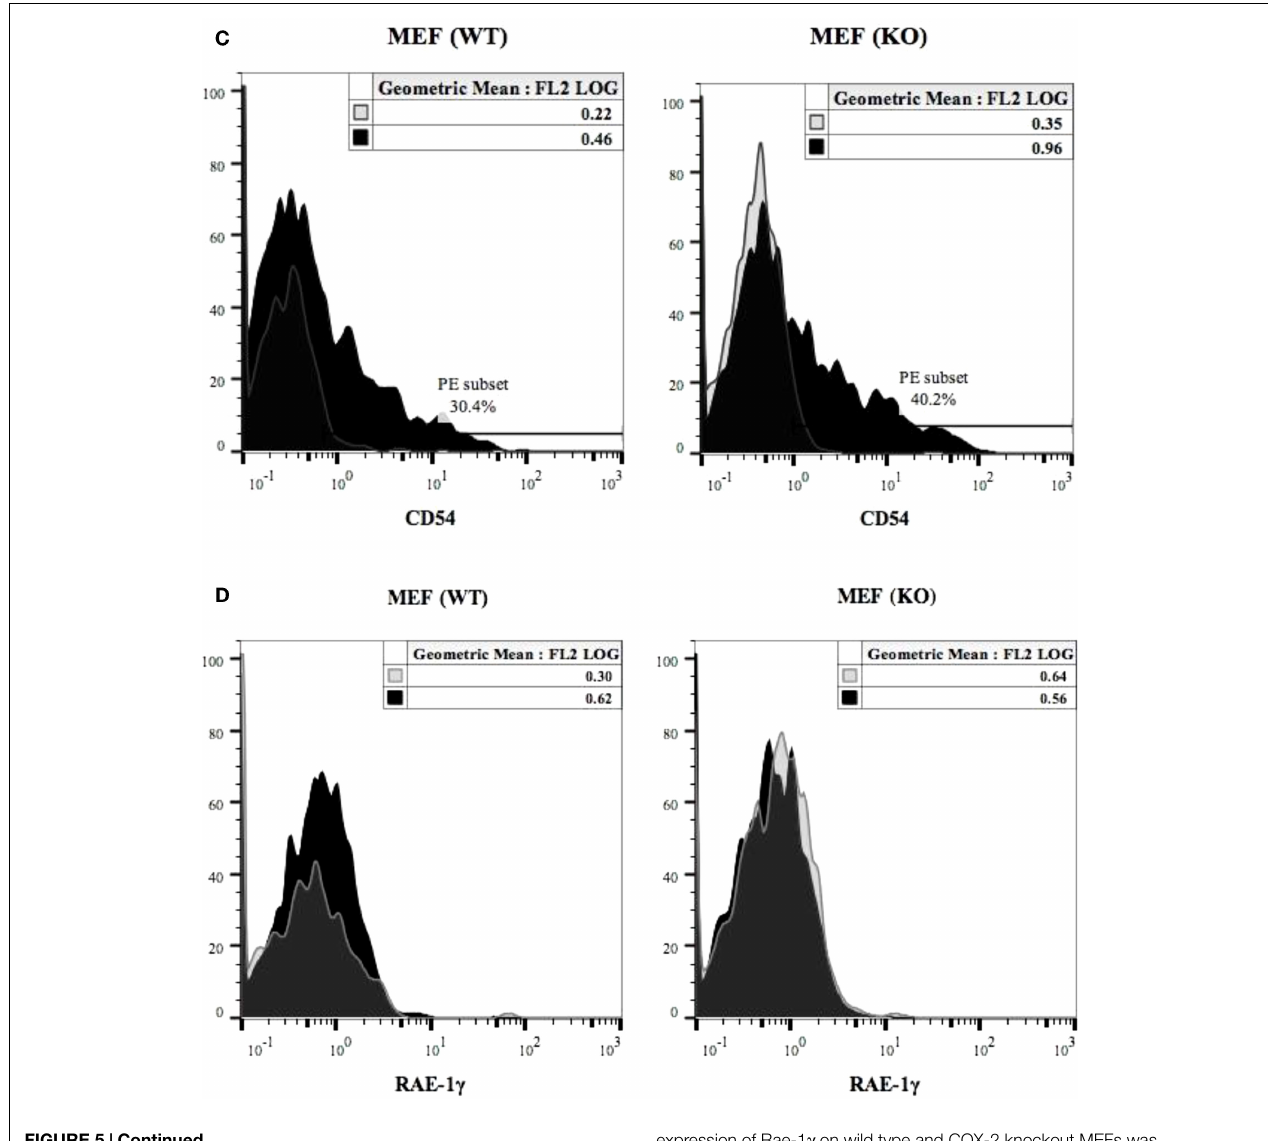
FIGURE 5 | Continued The surface expression of MHC class-I (A) , B7H1 (B) , and CD54 (C) on wild type and COX-2 knockout MEFs were assessed using staining with PE-conjugated antibodies followed by flow cytometric analysis. The surface